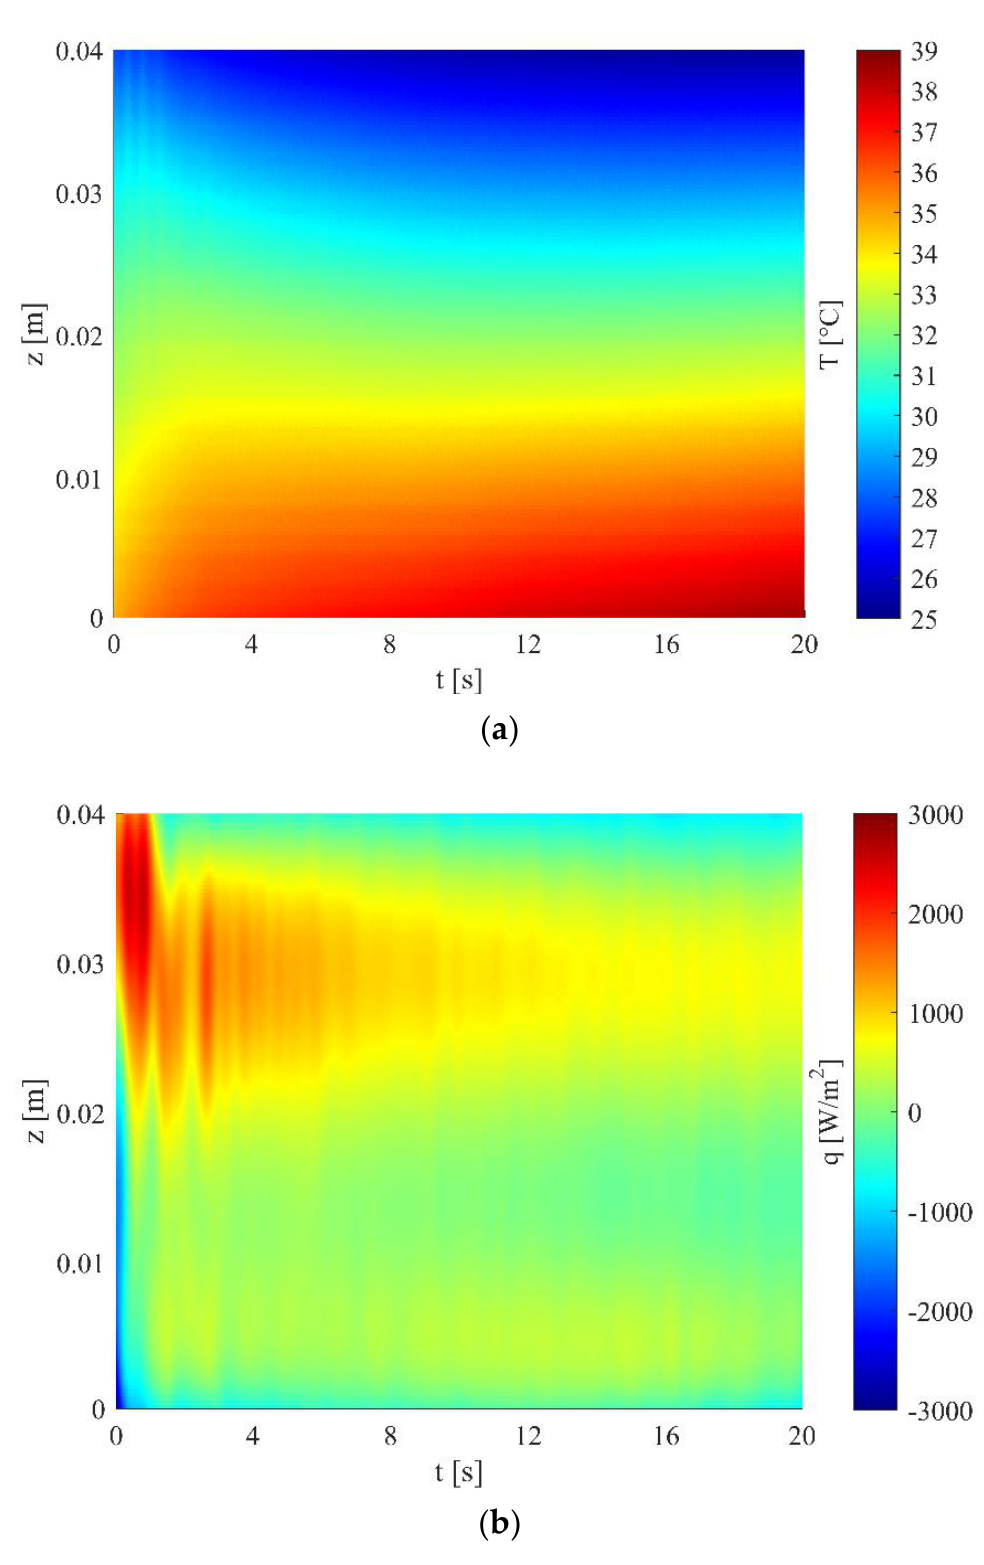
Figure 8. Space – time temperature distribution acquired by means of thermography ( a ) and resulting wall-to-fluid heat flux q ( b ); (channel 8, horizontal orientation, Q = 50 W).